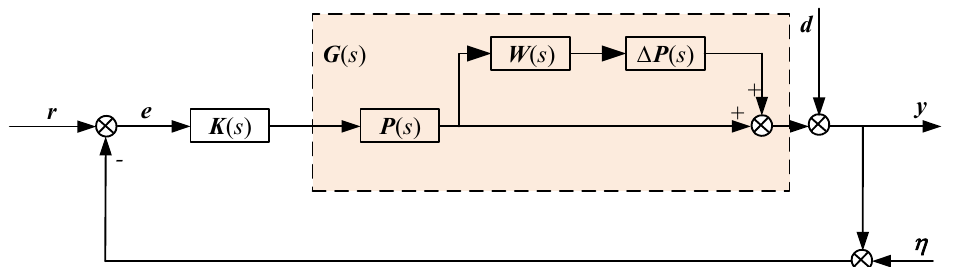
Figure 5. Multiplicative uncertain feed-back control